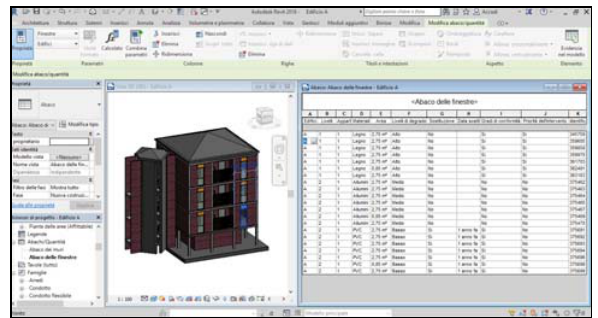
Figure 5. Objects, data and information in Revit